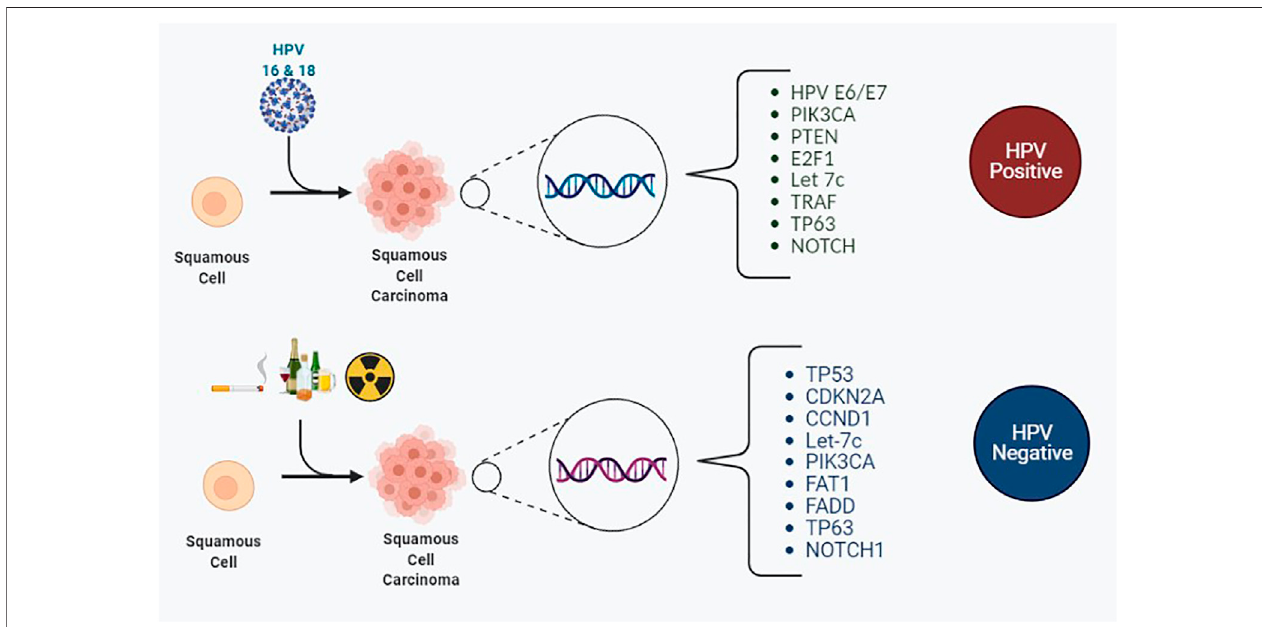
FIGURE 3 | The most frequently encountered somatic mutations for HPV positive and HPV negative squamous cell carcinomas of the head and neck region.